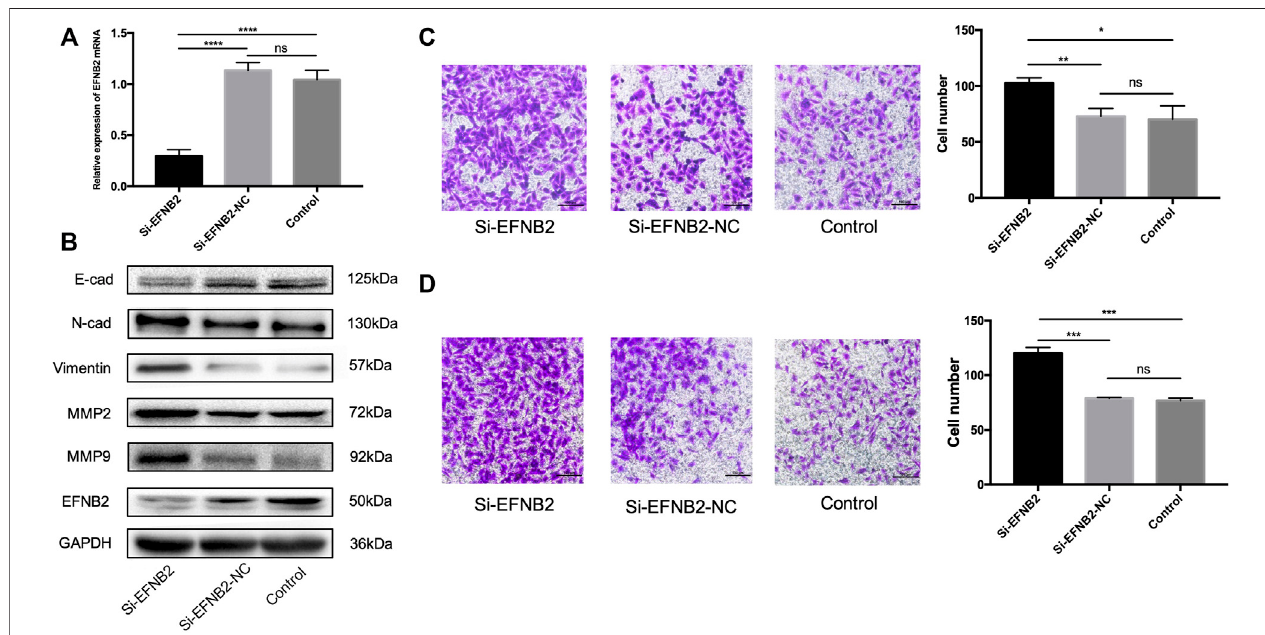
FIGURE4| EFNB2downregulation promotes themigrationand invasionofHTR-8/SVneocells. (A) EFNB2mRNAexpressionexaminedaftertransfection ofHTR- 8/SVneo cells with siRNA for EFNB2. (B) Levels of EFNB2 and EMT-related proteins detected after 48-h transfection. (C,D) Transwell migration and invasion assays showing higher numbers of migrated and invaded cells in the si-EFNB2 group than in the NC group (×200). All data are presented as the mean ± standard deviation. EFNB2, Ephrin-B2; Si, siRNA; NC, negative control; EMT, epithelial-mesenchymal transition. * P < 0.05, ** P < 0.01, *** P < 0.001, and **** P < 0.0001.